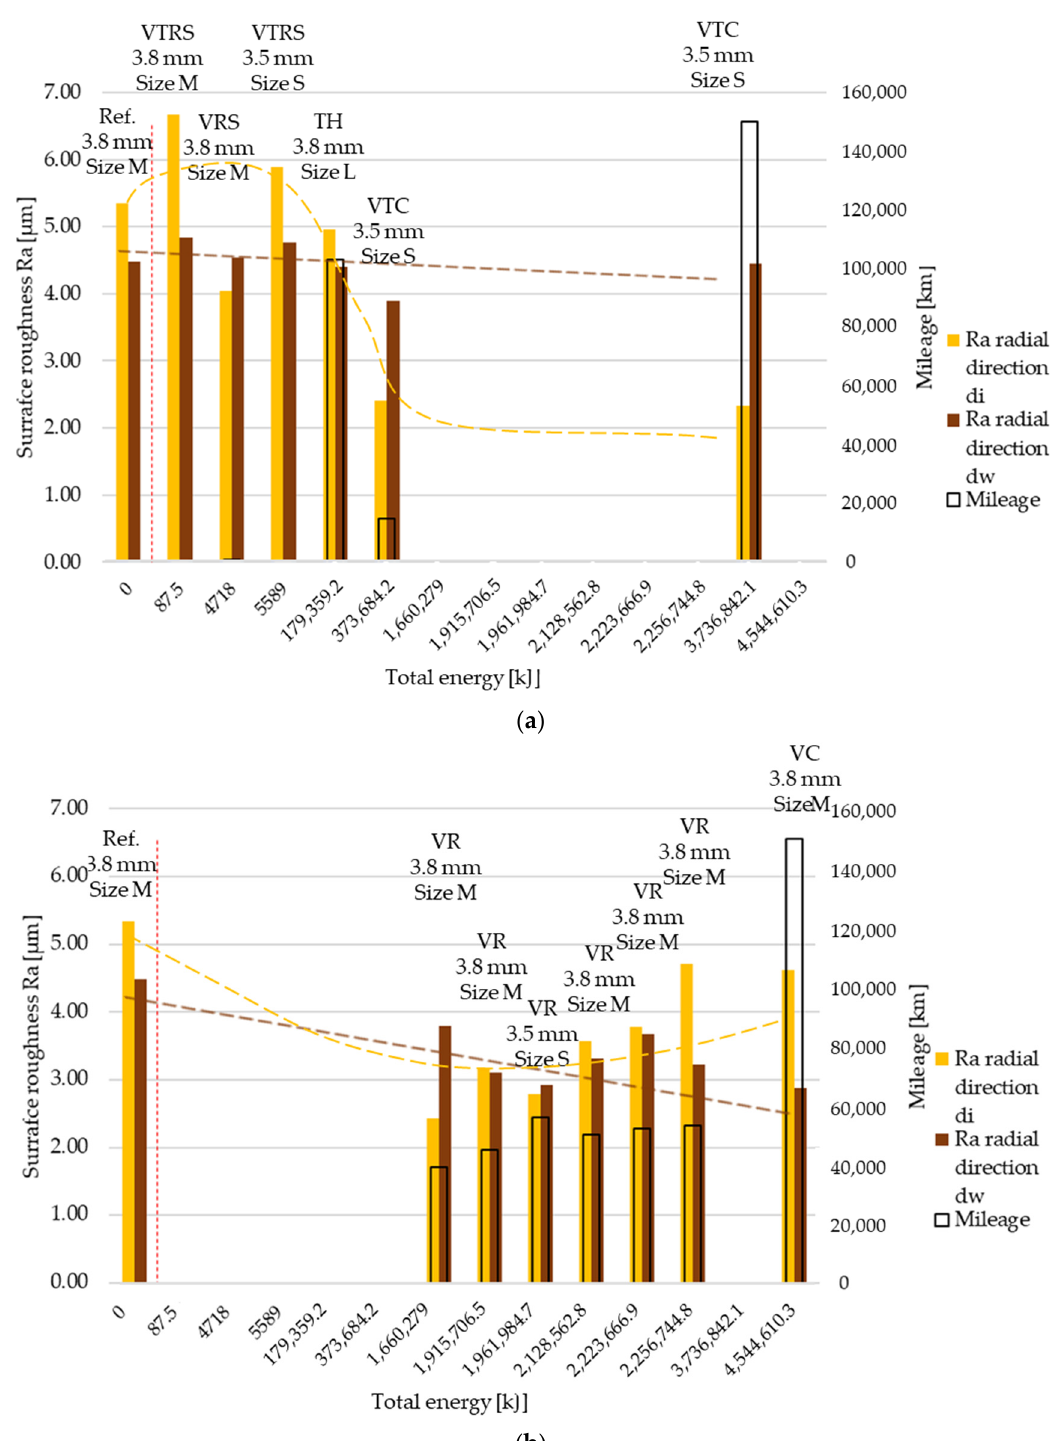
Figure 5. ( a ) Ra surface roughness values, radial direction–trend 1: clutch killer tests. ( b ) Ra surface roughness values, radial direction–trend 2: moderate tests.